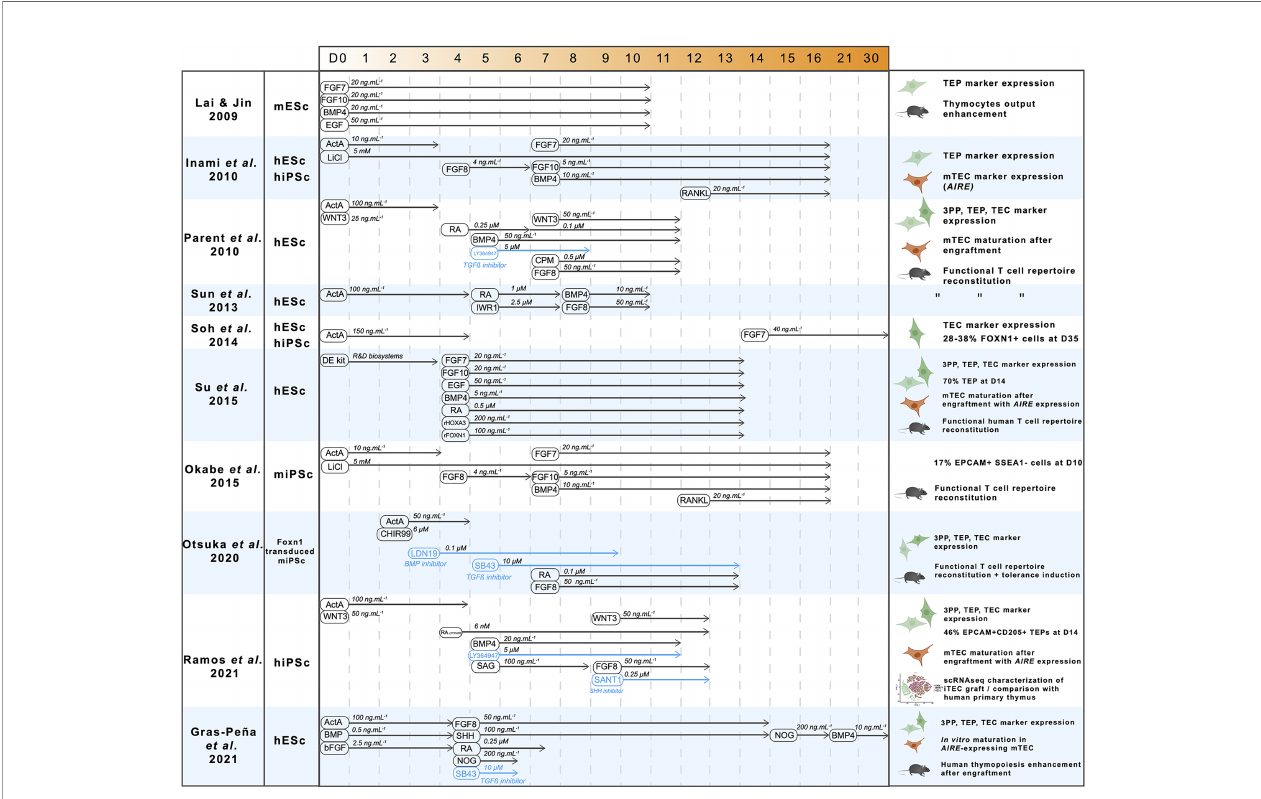
FIGURE 3 | A synthesis of pluripotent stem cells thymic differentiation strategies. A decade of advances in thymic differentiation resulted in perfected protocols allowing production of mature mTEC by mimicking the thymic organogenesis in vitro . For each reference, cell type used, pathway-modulating molecules timings and concentrations are indicated, as well as results in terms of nature of the obtained cells and their ability to induce T cell maturation. ActivinA (ActA), Fibroblast growth factors 7,8,10 (FGF7-8-10), Bone Morphogenetic Protein 4 (BMP4), LiCl (Lithium Chloride), Retinoic acid (RA), Cyclopamine (CPM, hedgehog inhibitor), Sonic Hedgehog (SHH), LY364947 (TGF b inhibitor), SB43 (TGF b inhibitor), Wingless family member 3 (WNT3), IWR1 (WNT inhibitor), Epidermal Growth Factor (EGF), CHIR99 (WNT3 agonist), LDN19 (BMP inhibitor), Noggin (NOG), SANT1 (Hedgehog inhibitor), Smoothened Agonist (SAG, Hedgehog